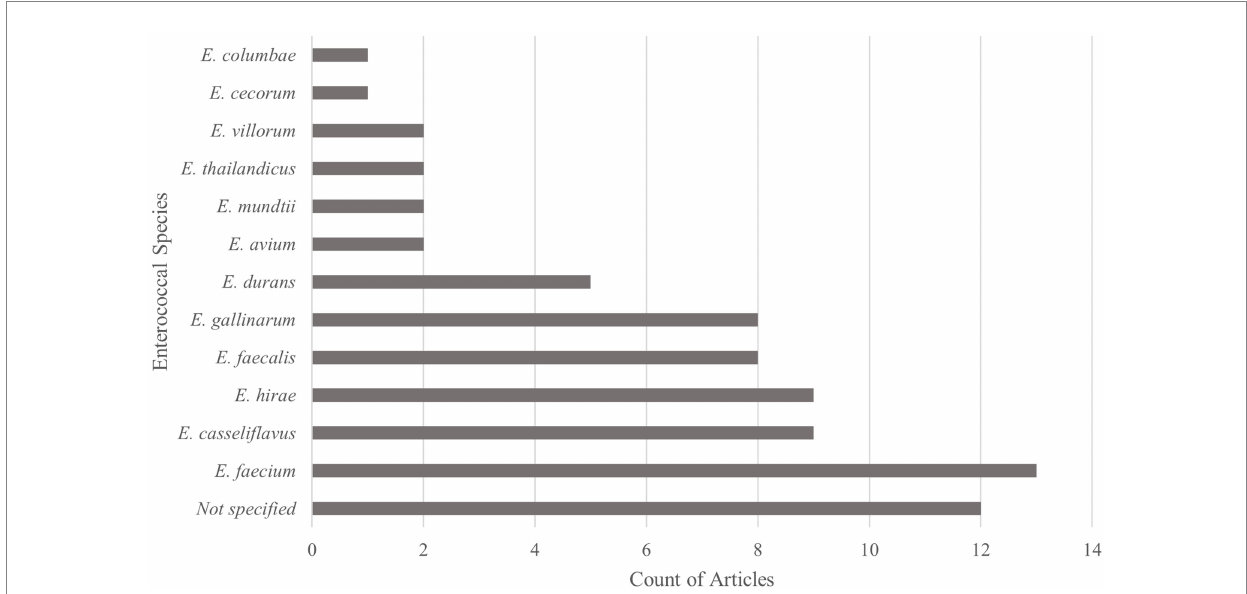
FIGURE 3 Types of enterococcal species reported within Scoping review of reported factors associated with antimicrobial resistant enterococci in Canadian beef cattle ( n = 26). Graph reports the number of articles reporting each enterococcal species. Thirteen articles discussed more than one Enterococcus species, with a maximum of nine species discussed within one